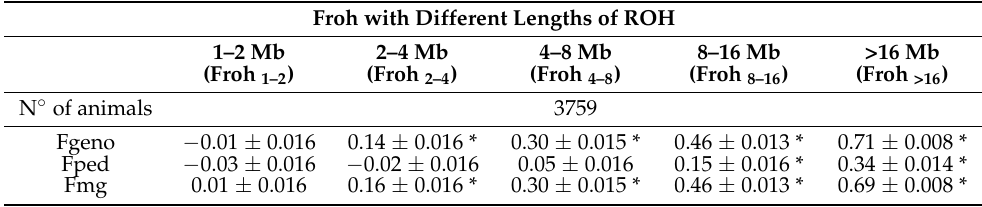
Table 3. Correlations ( ± SE) among the inbreeding coefficients between Fgeno, Fmg and Fped with Froh with different lengths of